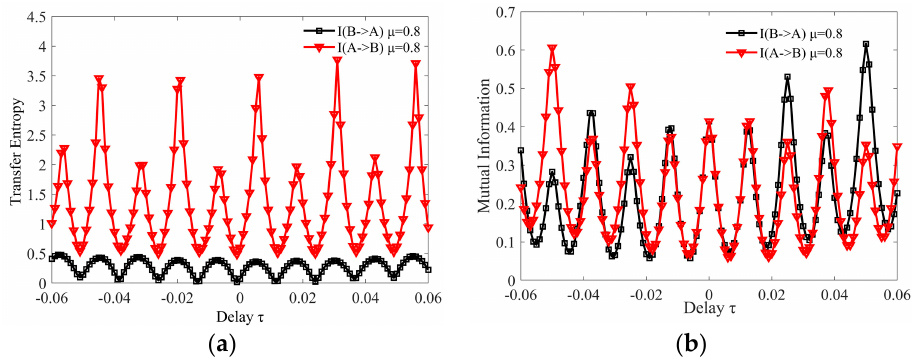
Figure 11. Comparison of results between transfer entropy and the mutual information method. ( a ) Result using the transfer entropy method, ( b ) result using the mutual information method.